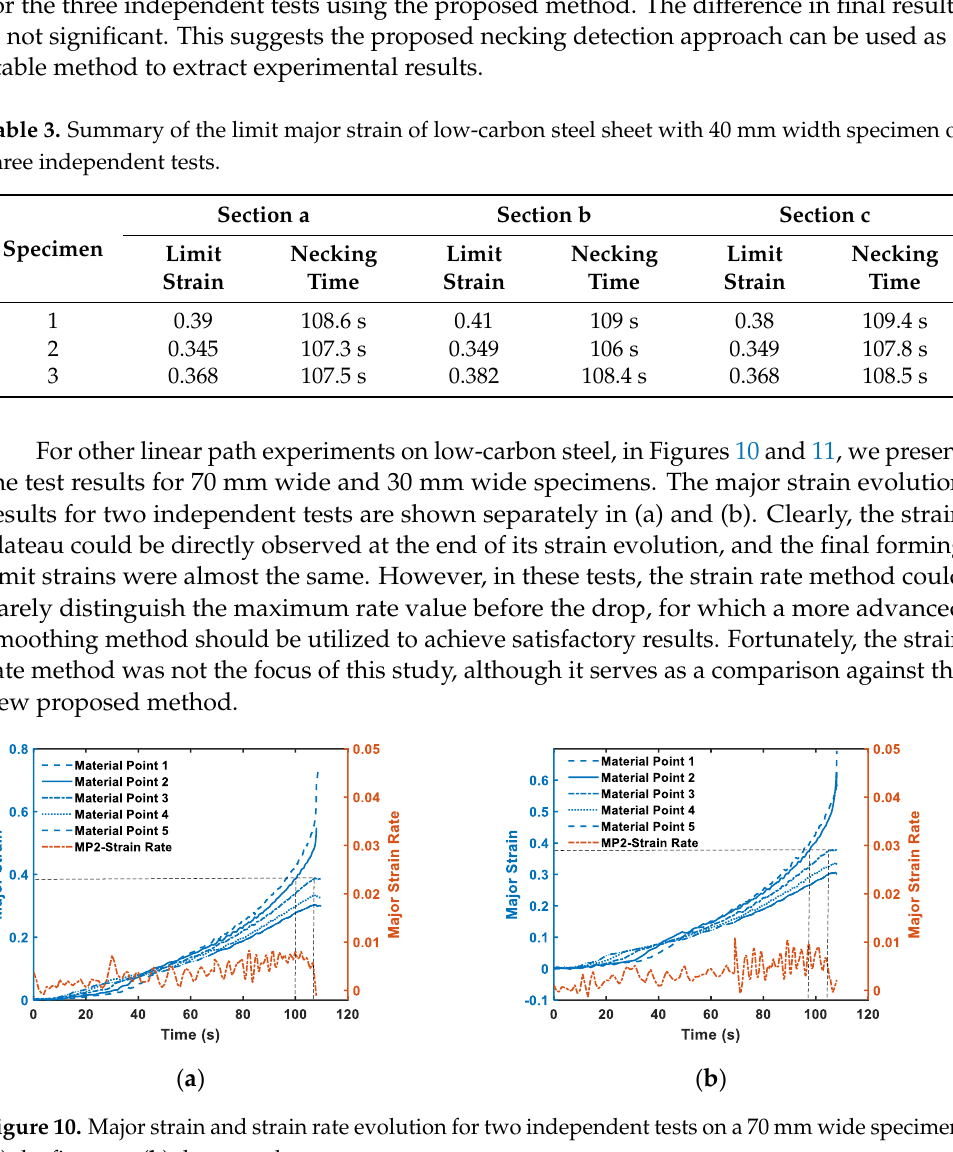
Figure 11. The major strain and strain rate evolution for two independent tests on a 30 mm wide specimen: ( a ) the first test; ( b ) the second test. 3.3. Localized Necking in DP Steel Sheets Standard Nakajima tests were performed using DP steel sheets, where seven differ- ent specimens were utilized to determine necking strain and further verify the stability of the proposed method. Specimens with widths of 25 mm (uniaxial tension), 110 mm (plane strain tension), and 180 mm (balanced biaxial tension) were taken as demonstrators in this section. Figures 12 – 14 present the detailed major strain and strain rate evolutions for two independent tests. For the uniaxial tension mode in Figure 12, the strain rate method pro- duces a convex curve, where the maximum strain rate indicates the forming limit strain. The results of plane strain deformation mode in Figure 13 also show satisfactory agree- ment for the two independent tests, where a similar necking strain can be obtained through the new method. However, the experimental results for the balanced biaxial ten- sion mode in Figure 14 show no strain plateau, and the strain evolution of all selected material points monotonously increased without bifurcation phenomenon. The strain rate